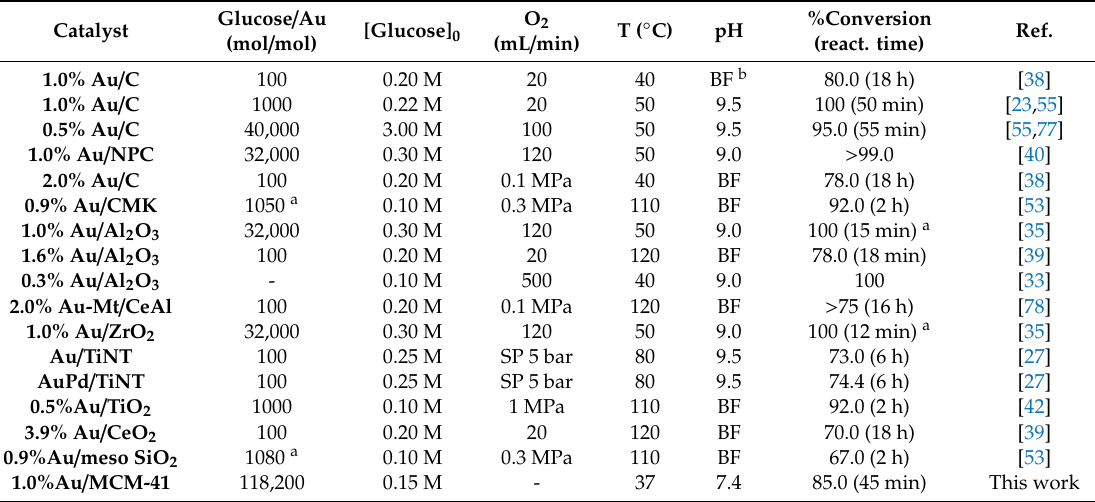
Table 1. Selection of Au-based catalysts reported for glucose